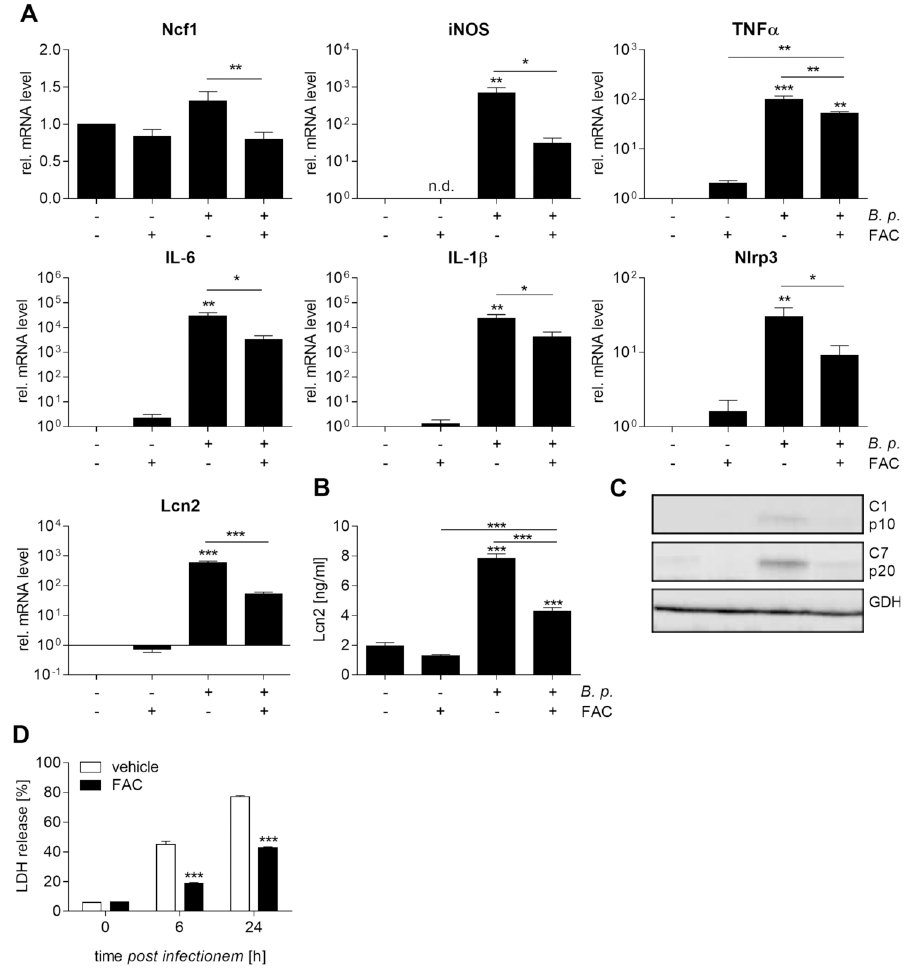
Fig 4. Iron supplementation impairs immune response pathways in B . pseudomallei -infected macrophages. BMM were treated with FAC (100 μ M) or corresponding vehicle (A. bidest) for 20 hours followed by infection with B . pseudomallei at MOI 50. (A) 24 hours after infection gene expression of neutrophil cytosolic factor 1 (Ncf1, n = 6), inducible nitric oxide synthase (iNOS, n = 4), tumor necrosis factor alpha (TNF α , n = 5), interleukin-6 (IL-6, n = 5), interleukin-1 β (IL-1 β , n = 4), NLR family pyrin domain containing 3 (Nlrp3, n = 4), and lipocalin 2 (Lcn2, n = 6) was analysed by qRT-PCR. (B) Lcn2 secretion in supernatants was measured by ELISA (n = 3). (A, B) Data are expressed as mean with SEM. Comparison of groups was done using one-way ANOVA and the Bonferroni post-hoc test ( (cid:3) p < 0.05, (cid:3)(cid:3) p < 0.01, (cid:3)(cid:3)(cid:3) p < 0.001). (C) Cleavage of caspase-1 and -7 and expression of GAPDH were detected by immunoblot in cell lysates of FAC- or vehicle-treated BMM at 24 hours after infection with B . pseudomallei . (D) Cytotoxicity was measured as lactate dehydrogenase (LDH) release in cell supernatants of FAC- or vehicle-treated B . pseudomallei - infected BMM. Data are presented as mean with SEM of triplicate determinations (n = 3). Statistical analyses were conducted using Student’s t- test ( (cid:3)(cid:3)(cid:3) p < 0.001).